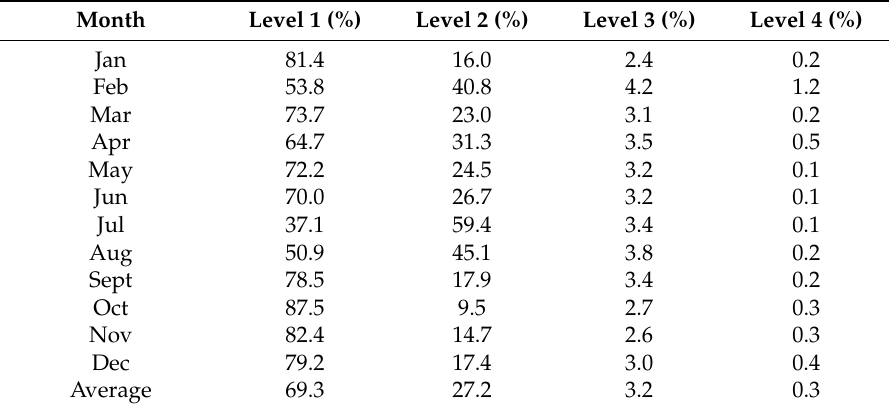
Figure 7. Monthly water transparency level maps in Lake Malawi. These maps were generated from monthly SD distribution maps (obtained from MERIS data using the Lee15 algorithm) based on the OECD classification system [36]. Table 7. Monthly percentage for each water transparency level shown in (Figure 7). Table 7 . Monthly percentage for each water transparency level shown in (Figure 7).